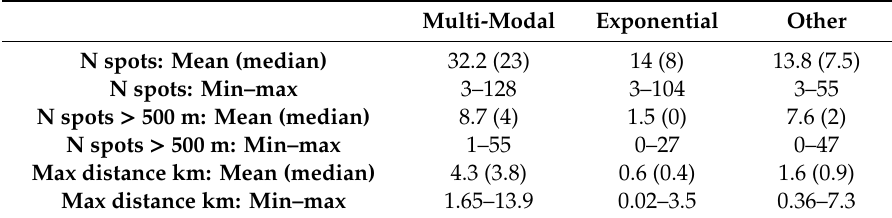
Figure 7. Frequency polygon distributions (bin width 250 m) for ten source fires with the longest maximum spot fire distance for each distribution type: Exponential group ( a ), multi-modal group ( b ), and other distributions ( c ). Table 1. Summary statistics for the three spotting measures by distribution